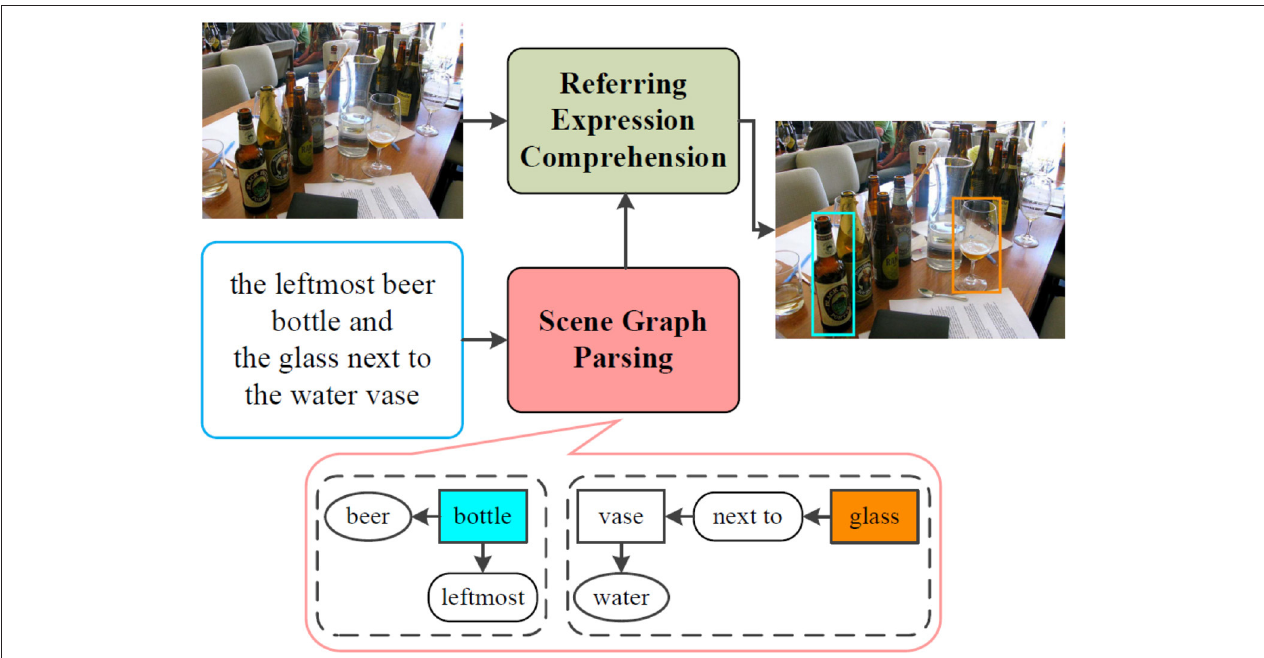
FIGURE 1 | The architectural diagram of the proposed interactive natural language grounding. We first parse the interactive natural language queries into scene graph legends by the scene graph parsing. We then ground the generated scene graph legends via the referring expression comprehension network. The mark rectangle in bottom encompasses the scene graph parsing result for the input natural language query. The rounded rectangles with black dashed lines denote the parsed scene graph legends, color shaded rectangles represent referents, no color shaded rectangle is an object, ovals indicate objects attributes, rounded rectangles act for edges which indicate relations between target and other objects. The same color of the bounding boxes in the output image and the referents in the generated scene graph legends denotes a